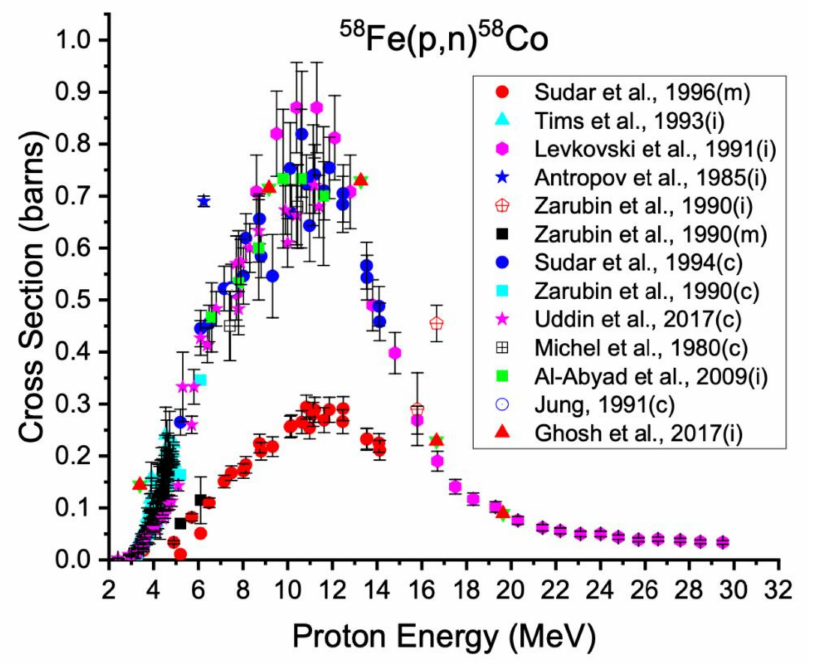
Figure 2. Cross section data for production of cobalt-58m and cobalt-58g from iron-58 [29–39].